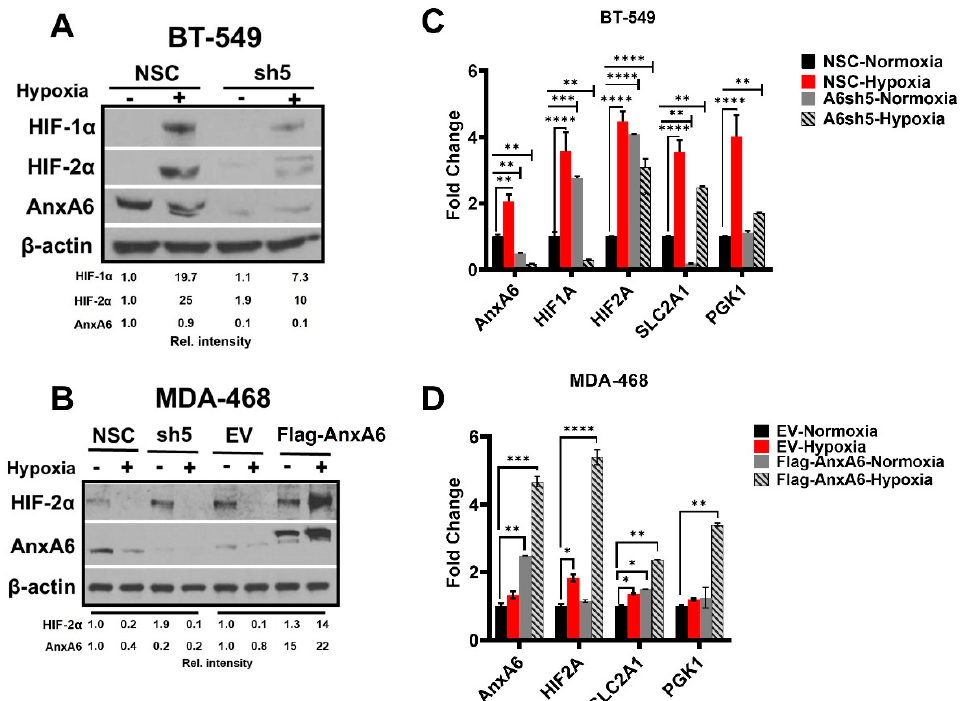
Figure 2. Altered Expression of AnxA6 influences HIF-1 α and/or HIF-2 α . ( A ) AnxA6 downregulation in the representative mesenchymal-like BT-549 TNBC cells. ( B ) Control and AnxA6 downregulation as well as empty vector and AnxA6 overexpression in the representative basal-like (MDA-468) TNBC cell line. Cells were incubated under hypoxic conditions for 96 h, and whole cell lysates were assessed by Western blotting using antibodies against HIF-1/2 α and AnxA6. Detection of β -actin was used as a loading control. ( C , D ) Effect of AnxA6 expression status, and hypoxia on the mRNA expression of HIF-1/2A , and downstream target genes. In parts C , D , each bar represents the mean ± SEM of duplicate analysis from three independent experiments. Asterisks (ns p > 0.05; * p ≤ 0.05; ** p ≤ 0.01; *** p ≤ 0.001; **** p ≤ 0.0001). p- values were analyzed by Two-way ANOVA.